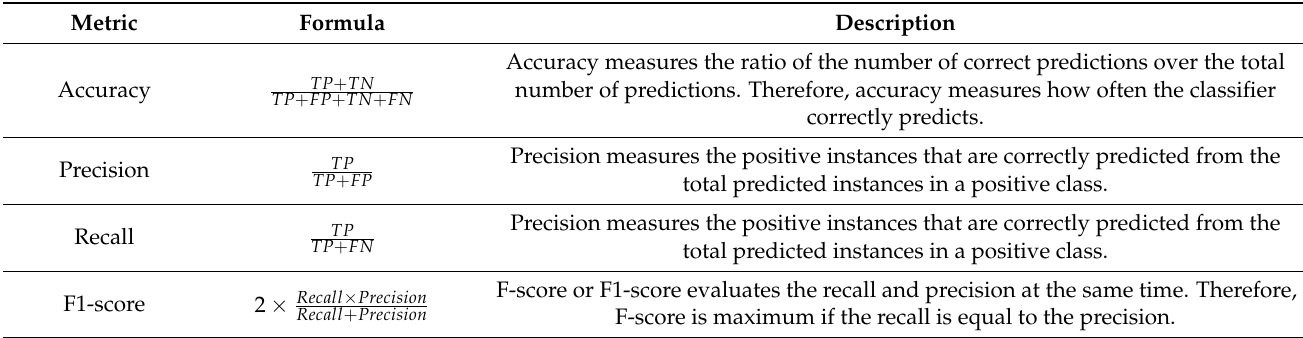
Table 2. Formulas of evaluation